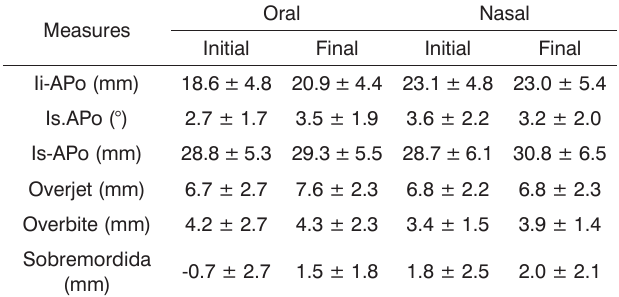
Figure 2. Angular measures which analyze the upper (Is.Apo) and lower (Ii.Apo) incisor tilt in relation to the Apo reference line.